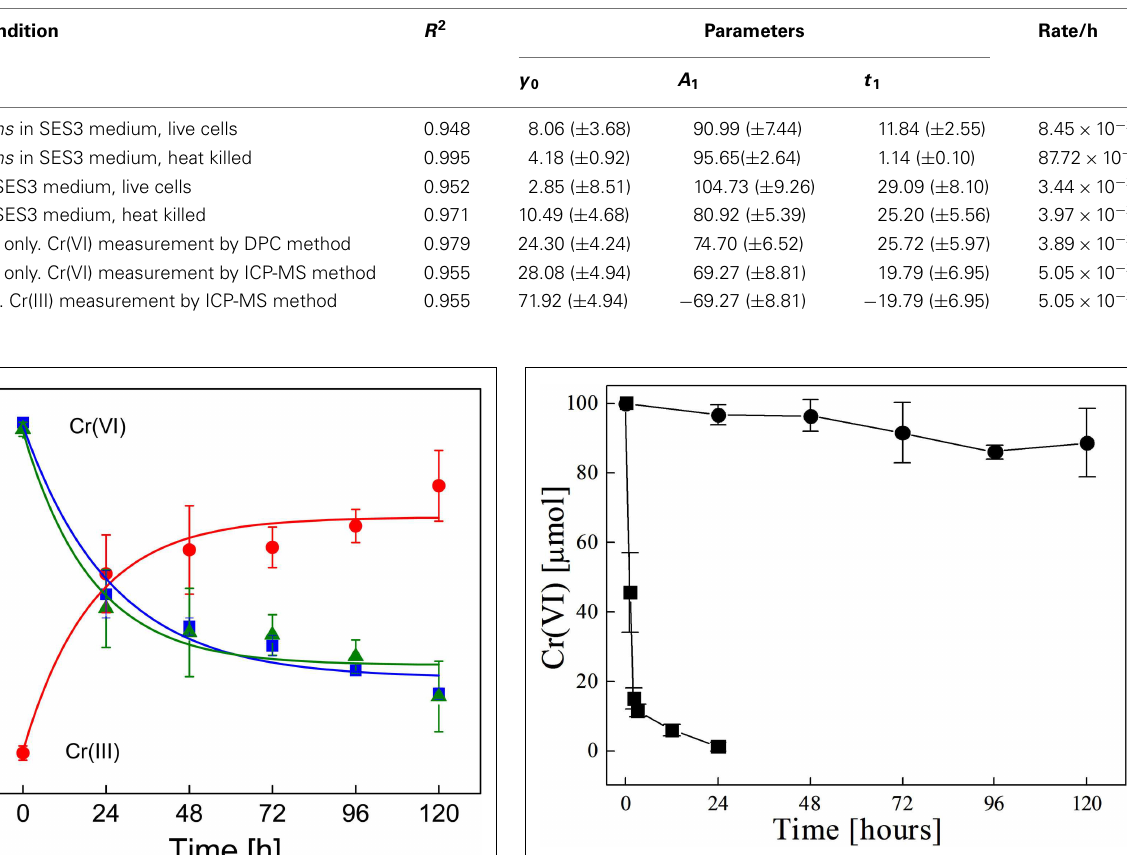
Table 1 | Parameters obtained from non-linear curve fitting.